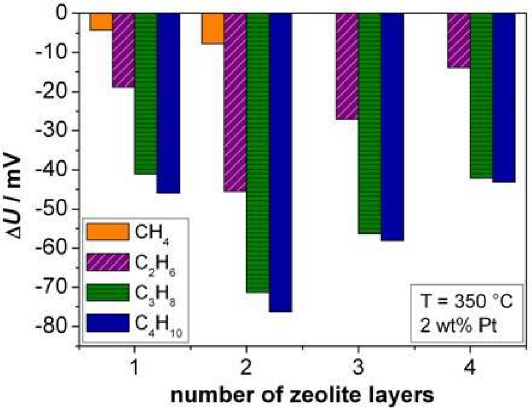
Figure 10. Δ U for different alkanes in dependence of the number of zeolite